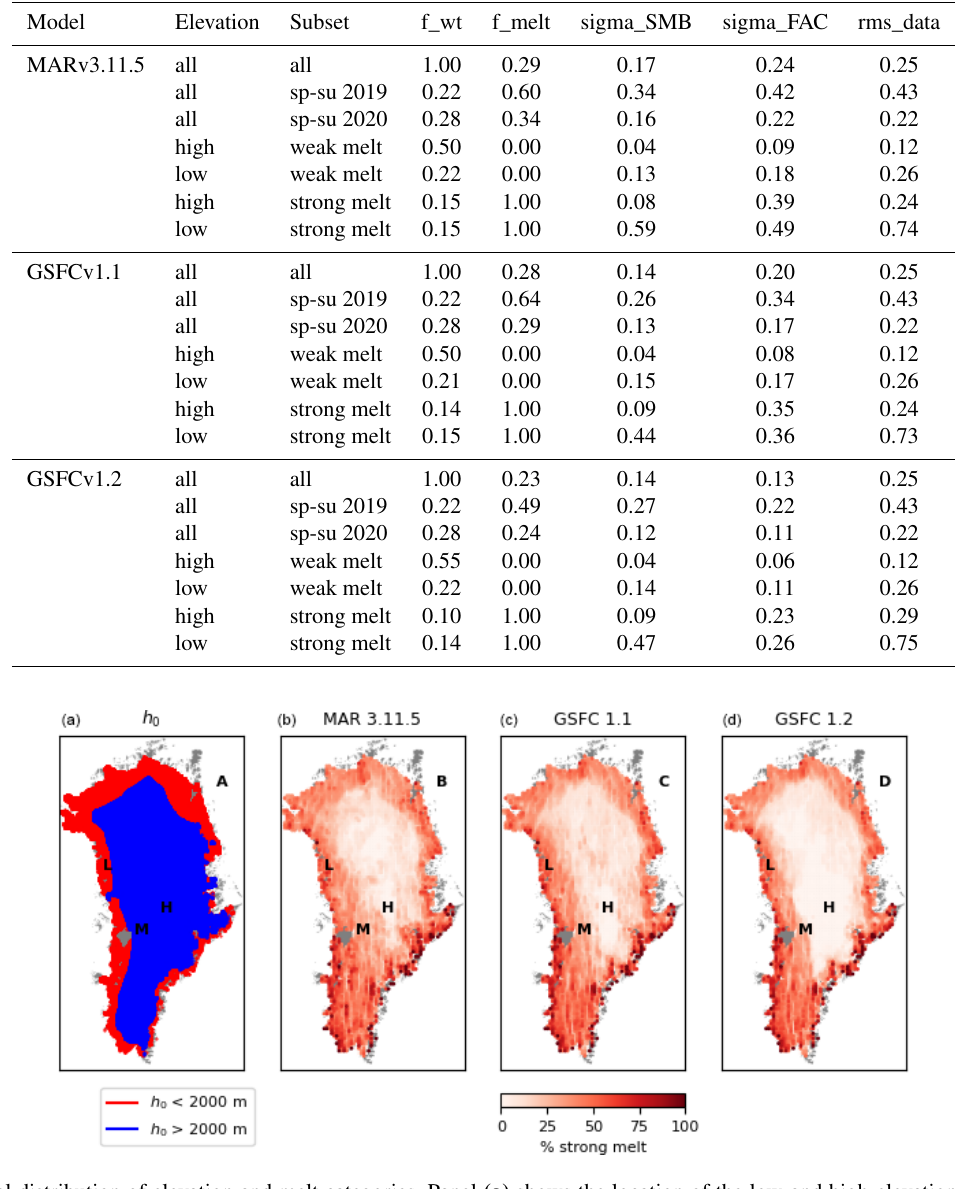
Table 1. Properties of subsamples of the models. The elevation and subset columns indicate the subsample of data for which the statistics were calculated. The elevation column indicates “low” for elevations below 2000m, “high” for elevations above 2000m, or “all”. The subset column indicates “strong melt” for data for which z melt > 0 . 2 | dh m | , indicates “weak melt” for data for which z melt < 0 . 2 | dh m | , or indicates temporal divisions of the data. The “f_wt” column indicates the fraction of the total data weight for each subsample of the data. The f_melt column indicates the fraction of points in each subsample that fell into the strong-melt category.